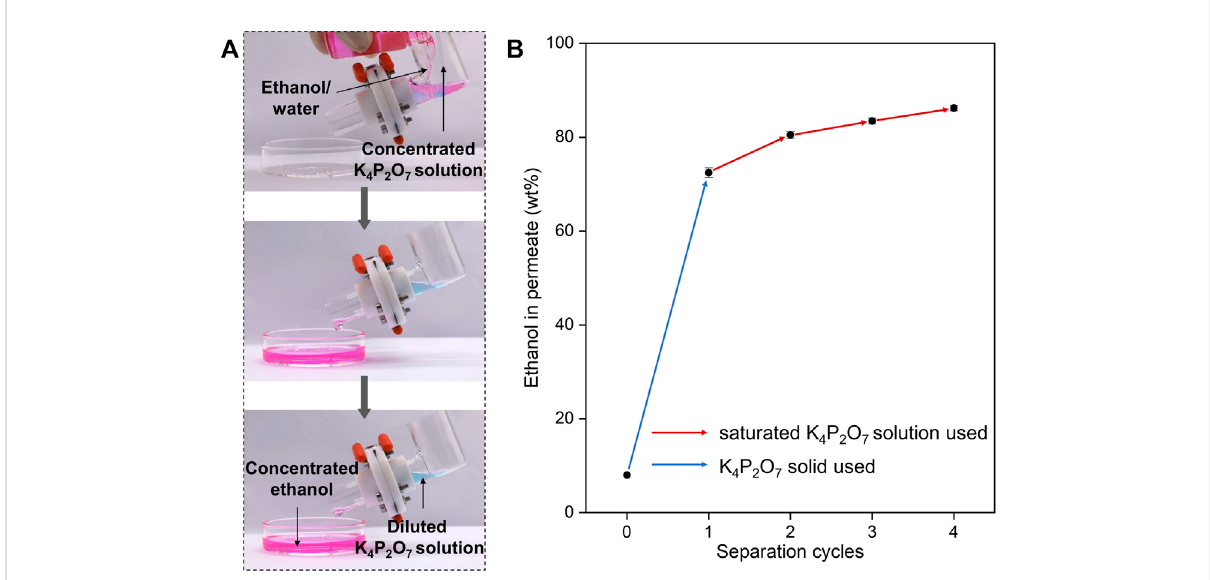
FIGURE 4 Demonstration of the ethanol/water separation. (A) Video captures of separation process using concentrated K 4 P 2 O 7 solution as the inductive agent.IntroducingconcentratedK 4 P 2 O 7 solutiontotheethanol/waterresultsinselectivepermeationandcollectionofethanolwithK 4 P 2 O 7 solution being blocked. (B) Cycled separation for ethanol/water. Started ethanol in feed is 8 wt% and equal mass of solid K 4 P 2 O 7 was added for separation. Each cycle takes the permeate of previous cycle as the new feed, and equal mass of saturated K 4 P 2 O 7 solution was